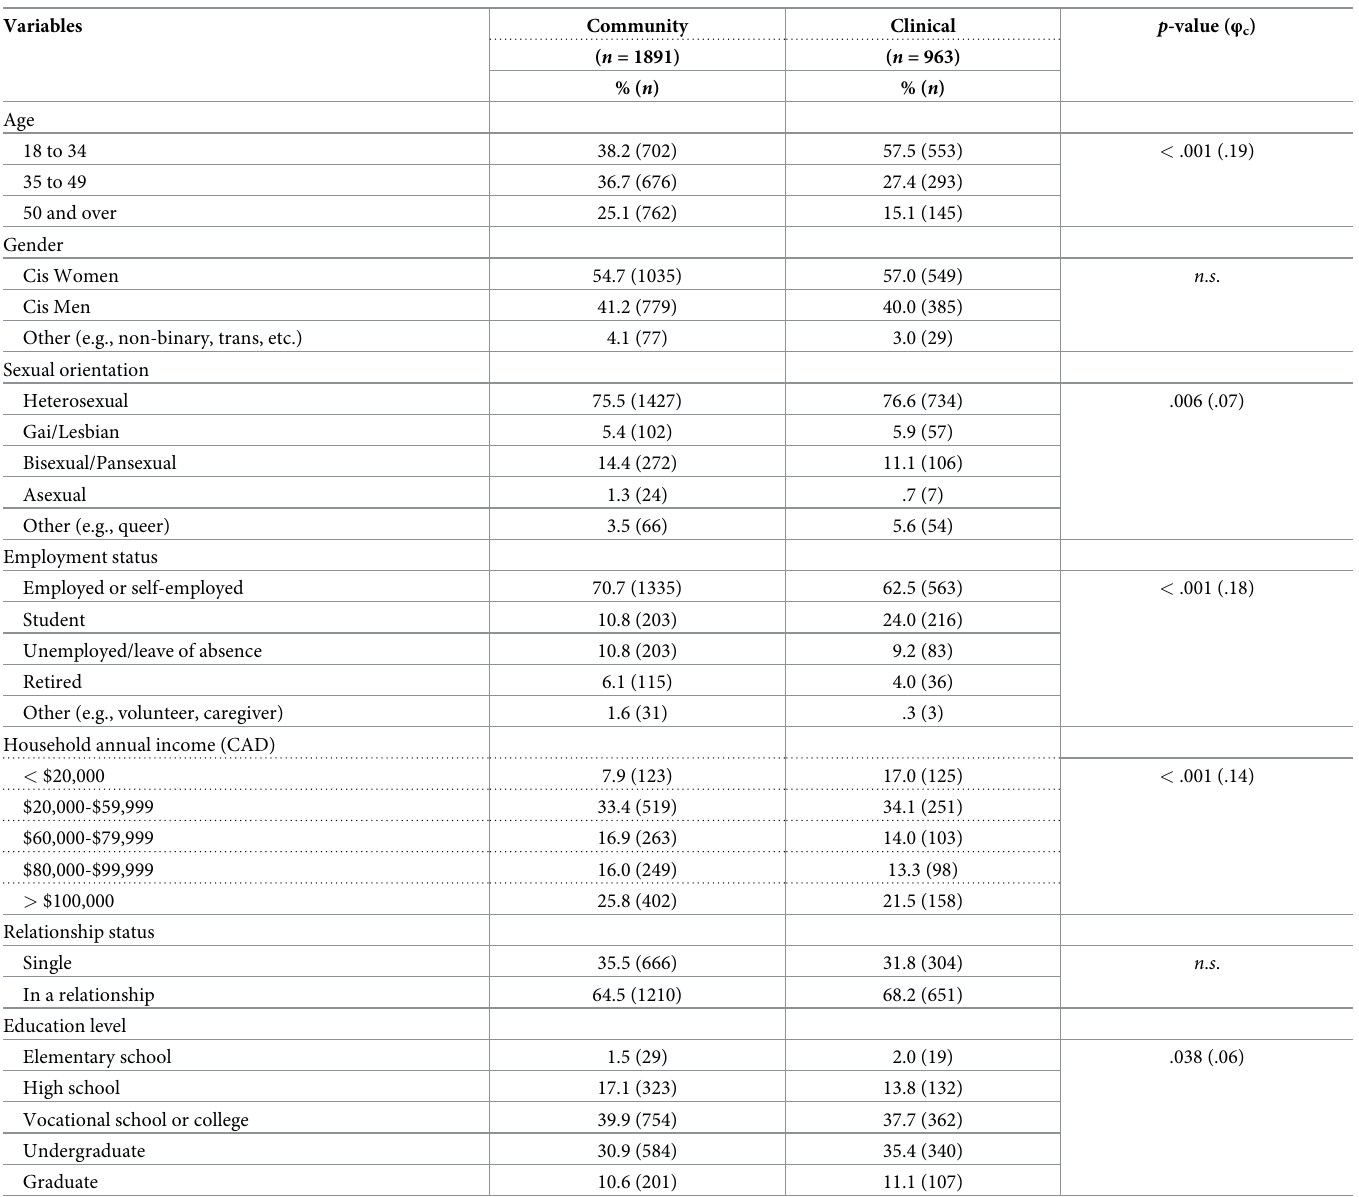
Table 1. Demographic characteristics of the community and clinical